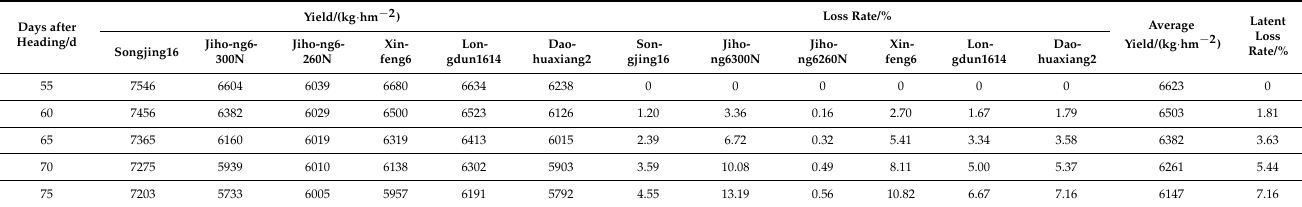
Table 2. Latent loss rate of six rice varieties on different days after heading